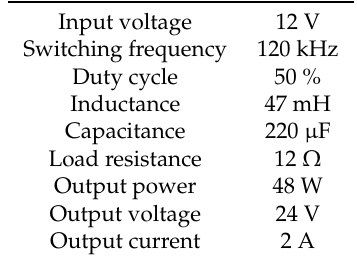
Table 1. Low power converter parameters.